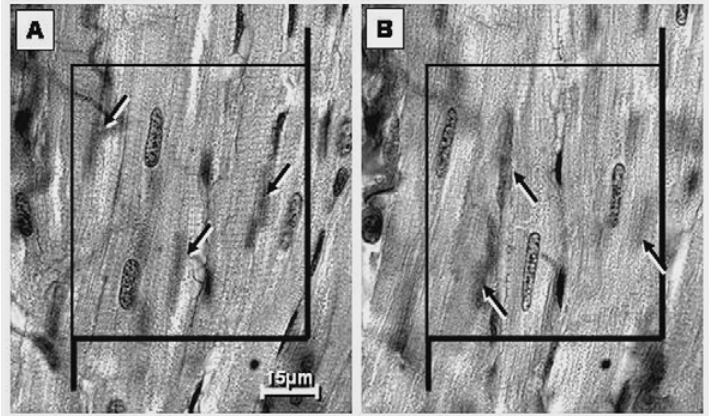
Fig. 16 – Example of a physical disector made with myocardium. The look-up plane is represented byA and the look-down plane is represented by B.Arrows show cardiomy- ocyte nuclei shadows in the opposite plane of the disector. If we consider the look-down plane forbidden three sharp nuclei are counted in A because these nuclei don’t hit the look-down plane (based on Pereira and Mandarim-de-Lacerda